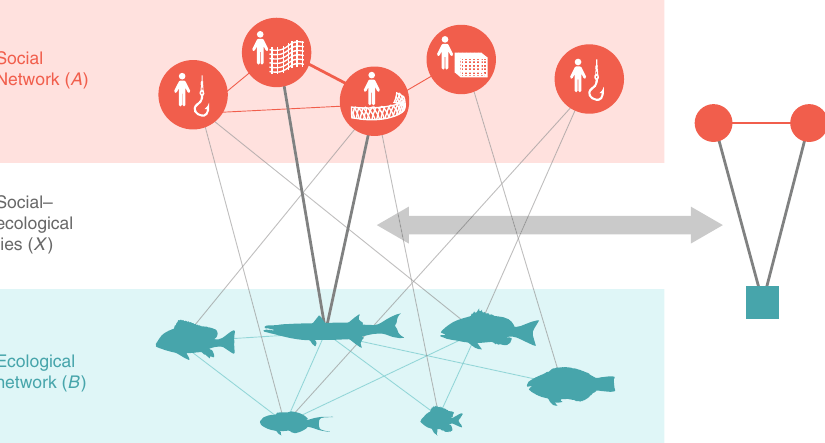
Fig. 1 A coral reef fi shery as a multilevel social – ecological network. An illustrative example of the integrative, social – ecological network modeling approach and key con fi guration of interest. The social network ( A ) captures key communication relationships between individual fi shers. The ecological network ( B ) captures trophic interactions among target species. In reef fi sheries, each fi shing gear type catches a diverse and overlapping, but distinct assemblage of species in B . Individual fi shers are thus linked to particular fi sh species ( X ; social – ecological ties) depending on the type of gear they use (depicted in the nodes in A ). All nodes and links are representative of our empirical data. The multilevel structure ( A , B , X ) captures the dependencies that exist within the system, i.e., how features of social and ecological systems are interrelated both within and across levels. Full multilevel social – ecological networks can be disassembled into smaller building blocks, or key con fi gurations (right), that form the foundation for the larger system structure 4,68 . Here a form of social – ecological alignment is emphasized, i.e., social – ecological network closure, which captures the tendency for actors tied to the same resource to form cooperative communication